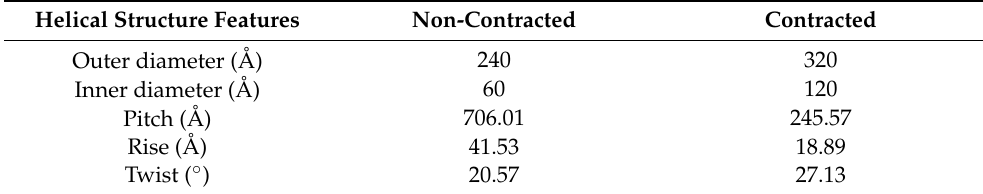
Figure 5. Non-contracted and contracted organization of the phage G tail sheath. Representation of 16 tail sheath subunits from a single strand of the six-stranded tail sheath of phage G in the non-contracted conformation (grey), and in the contracted conformation (cyan) cryo-EM structures in the top ( A ) and side ( B ) views. The tail tube density is shown in transparent grey. Table 2. Cryo-EM helical structure details of phage G tail sheath in non-contracted versus contracted states.